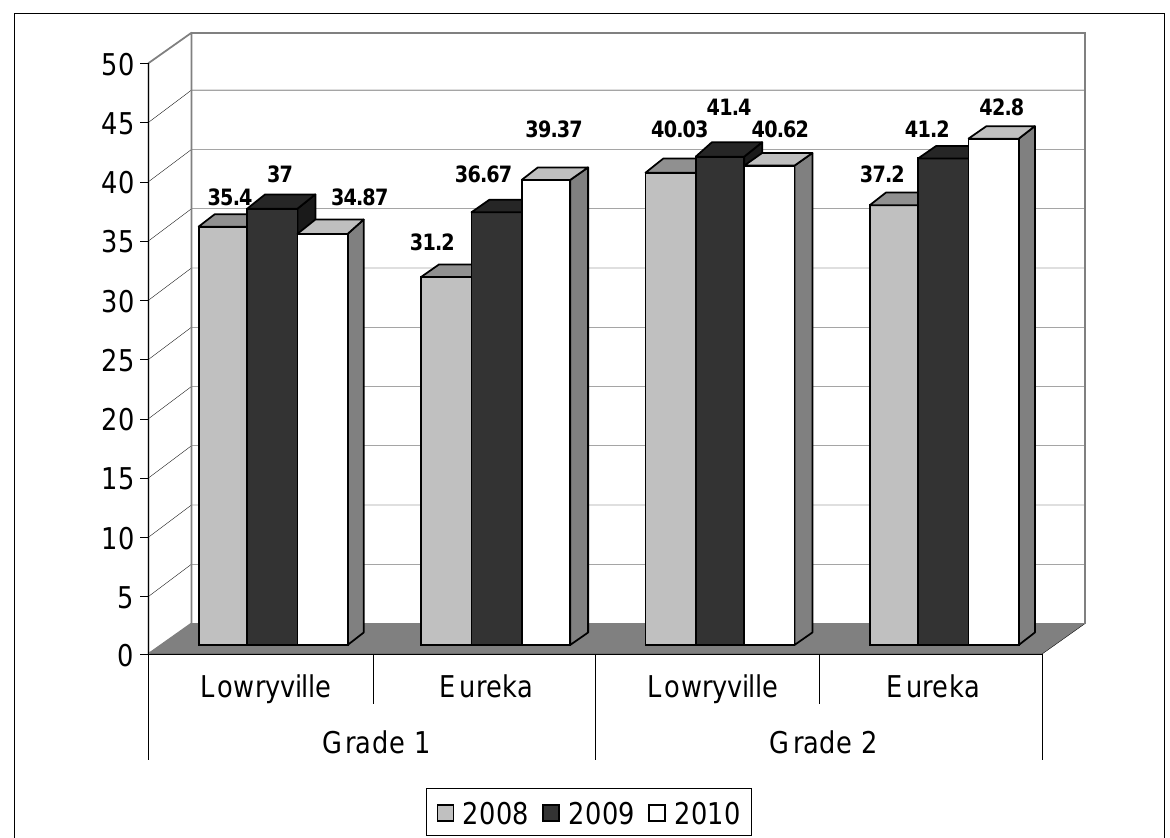
Figure 8 Mean Boehm-R Scores of Learners in Grades One and Two from 2008 to